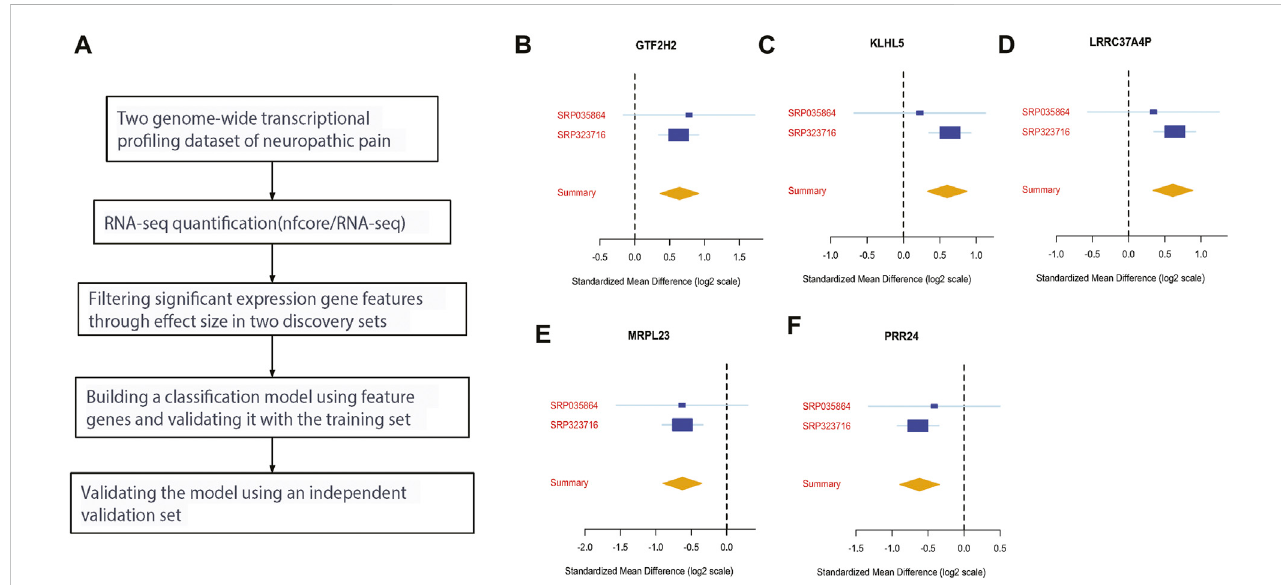
FIGURE 1 Discovery of fi ve differentially expressed genes in neuropathic pain. (A) An analysis work fl ow was used to identify and validate three differentially expressedgenes across training and validation datasets; (B – F) theeffect sizes offour upregulated genes(GTF2H2, KLHL5, LRRC37A4P, andMRPL23) and two downregulated genes (MRPL23 and PRR24) were